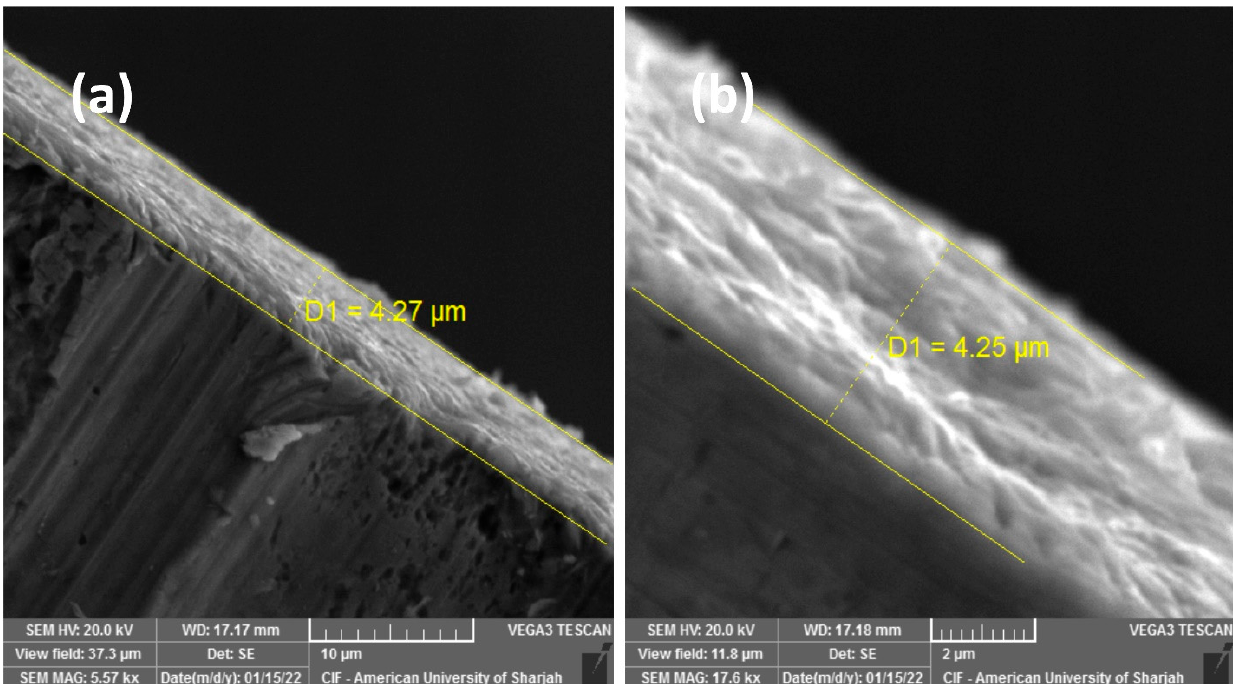
Figure 6. Cross section of the MoO magnifications